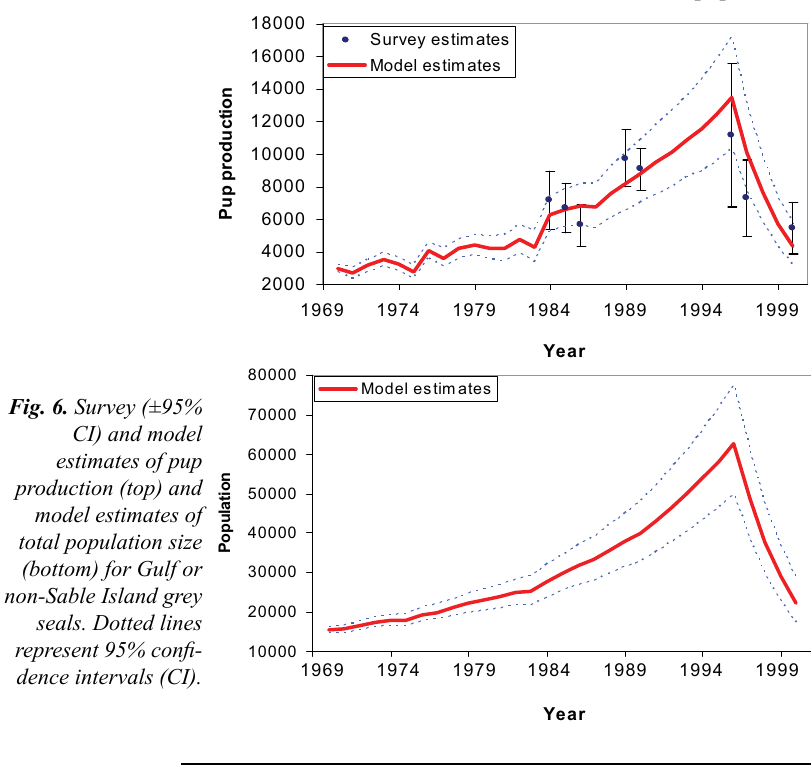
Grey seals in the North Atlantic and the Baltic